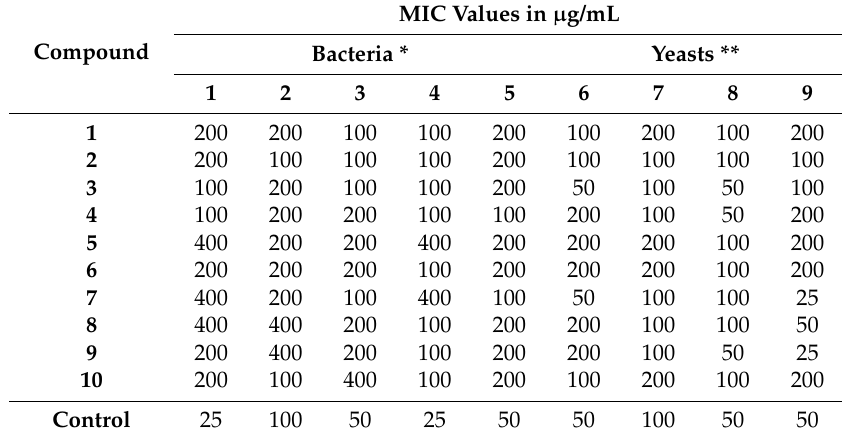
Table 1. Antimicrobial activity of compounds 1 – 10 .